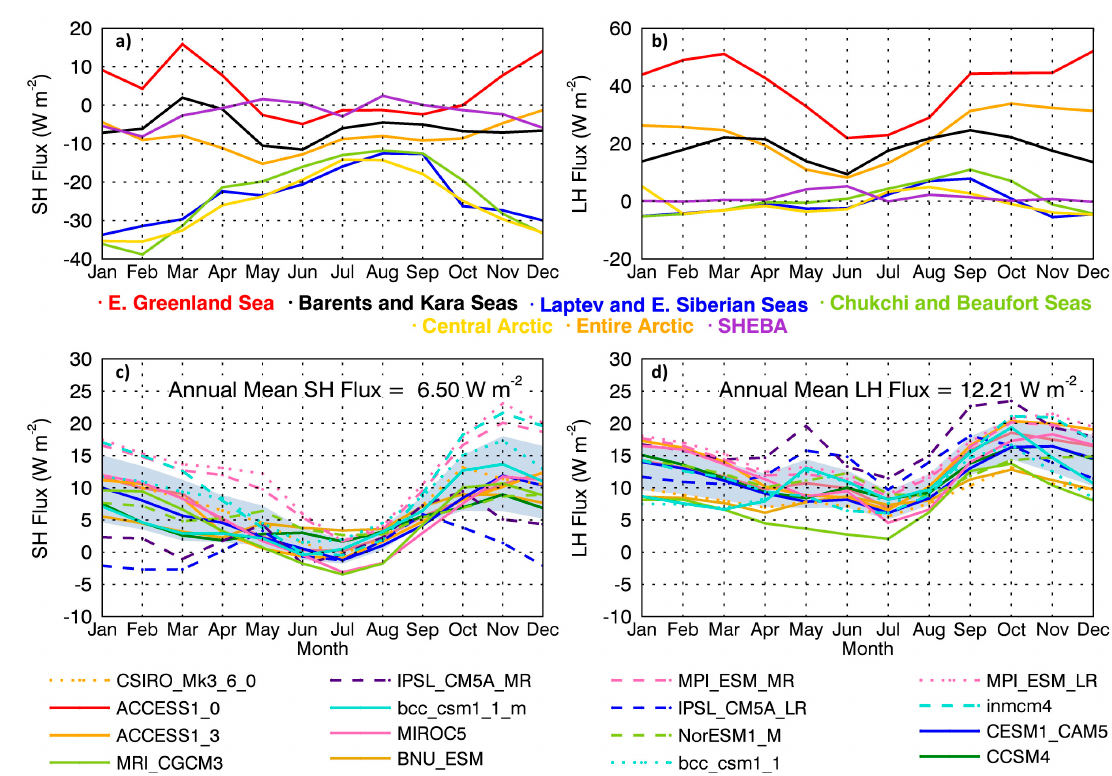
Figure 6. Top panels show satellite-retrieved annual cycles of ( a ) SH and ( b ) LH fluxes averaged from 2003–2015 for the Arctic Ocean domain (orange line) and several interesting regions (see legend). The annual cycle of SH and LH fluxes measured during SHEBA are shown in purple. Bottom panels show the present-day annual cycle of ( c ) SH and ( d ) LH fluxes averaged over all non-land gridboxes poleward of 60° N from a 16-member CMIP5 climate model ensemble using the RCP8.5 forcing, a high-emission scenario in which greenhouse gas emissions continue to rise throughout the 21st century. The value in the ( c ) and ( d ) represent the annual, ensemble averaged SH and LH fluxes. Present-day is defined as the first 20 years of the simulation (2006–2026).